Question: Express in one sentence what the figure is showing.
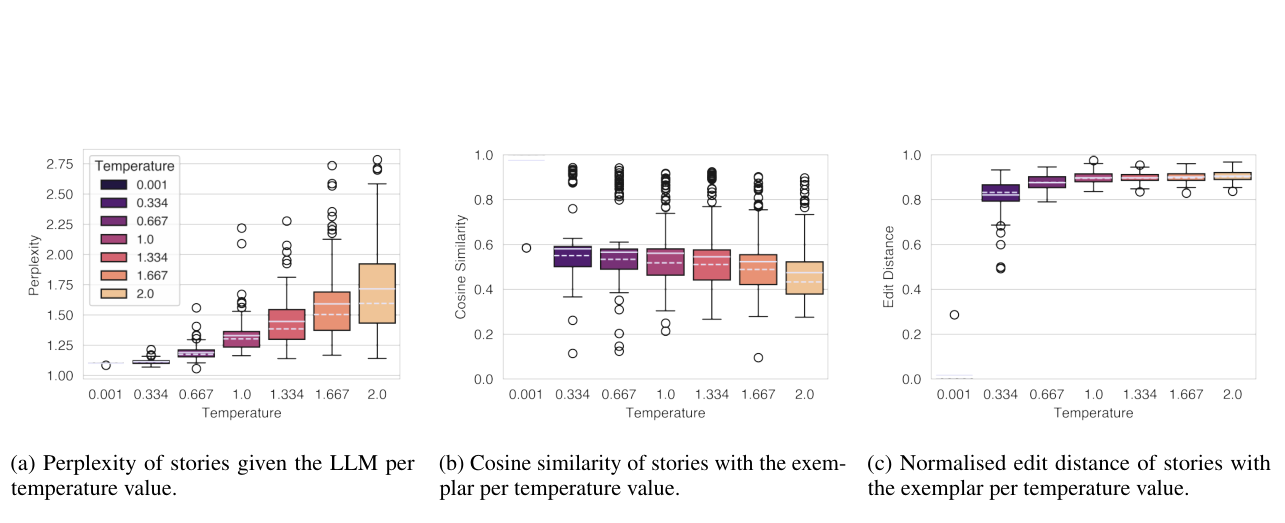
Answer: In (a), we see that the effect temperature has on the perplexity, the quality according to the LLM, of the output. Both, (b) and (c) suggest that higher temperatures do not imply more diversity on the semantic or lexical level, or that it further extends the range of possible outputs in the current context.